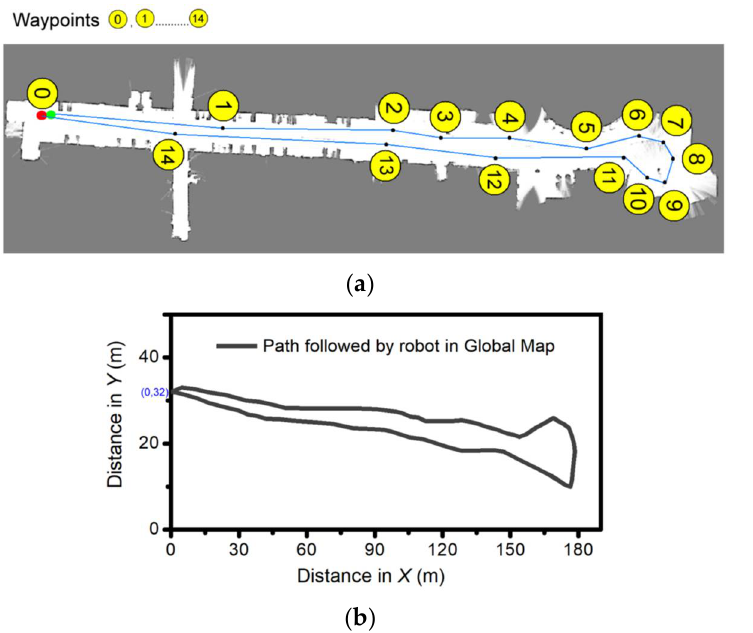
Figure 14. Map generated by individual robots overlaid on building blueprint.